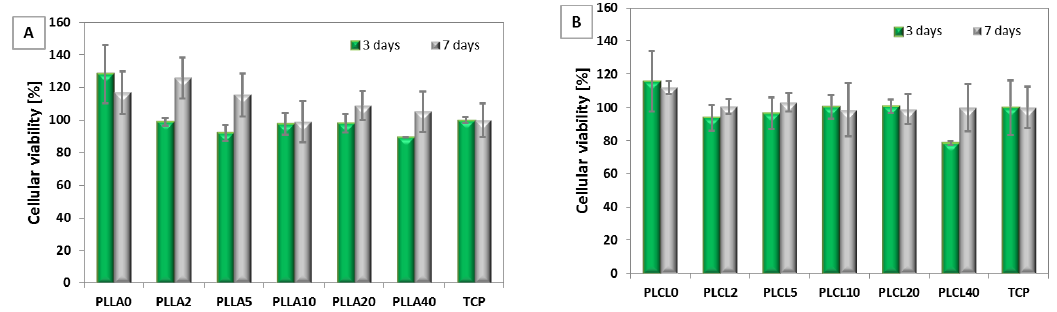
Figure 10. Cellular viability test on L929 cells after 3 and 7 days of cultivation on: ( A ) PLLA2, PLLA5, PLLA10, PLLA20, and PLLA40 in relation to PLLA0 (pure PLLA); ( B ) PLCL2, PLCL5, PLCL10, PLCL20, and PLCL40 in relation to PLCL0 (pure